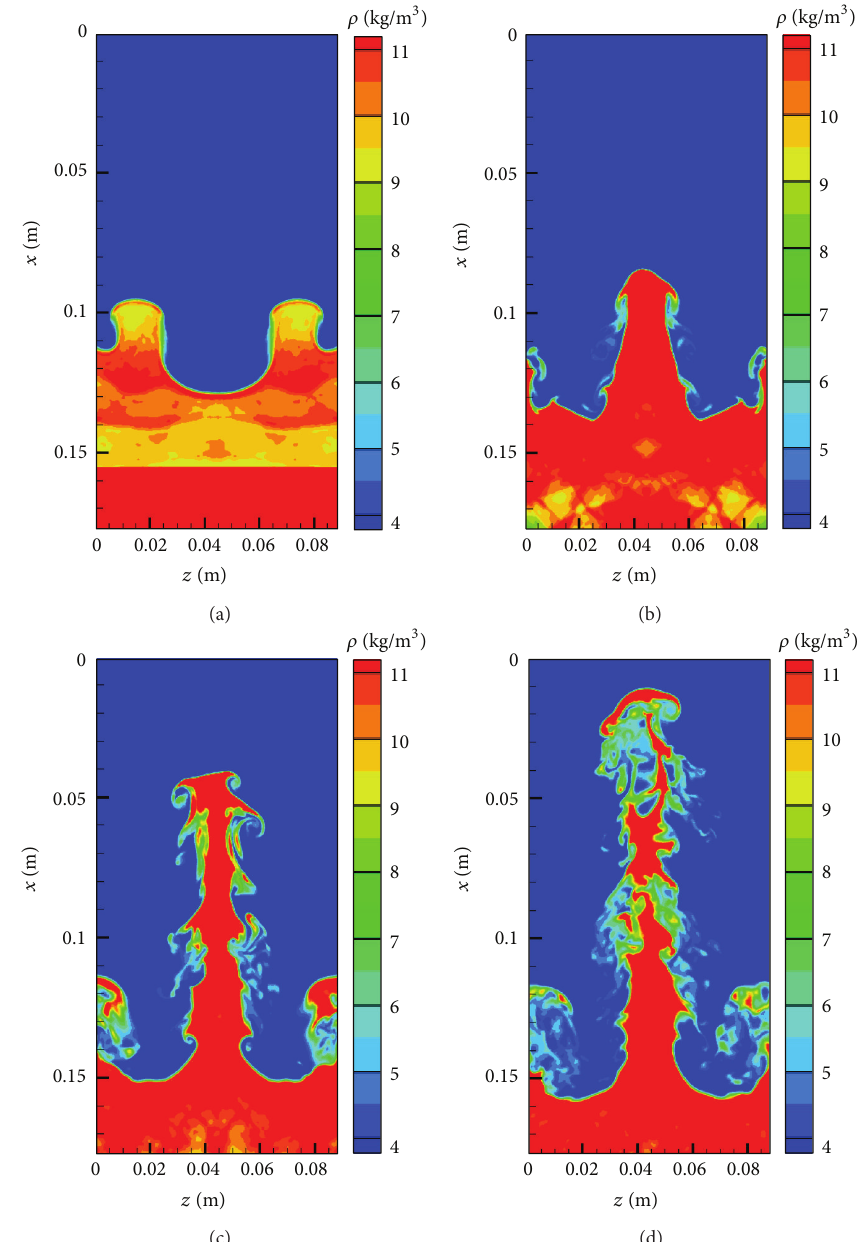
Figure 9: Instantaneous contours of density across centerline y -direction ( 𝑌 = 0 ) at (a) 𝑡 = 1 ms, (b) 𝑡 = 2 ms, (c) 𝑡 = 3 ms, and (d) 𝑡 = 4 ms.